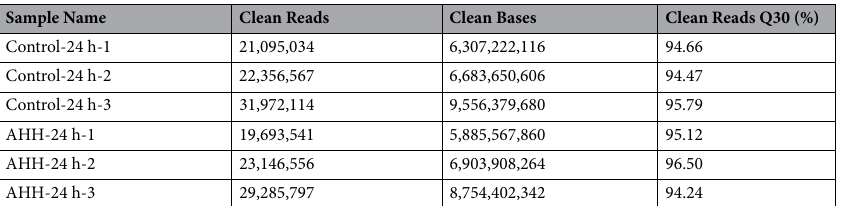
Table 1. Statistical analysis of transcriptome sequencing of the hippocampal tissue of spontaneous hypertensive rats (SHRs) exposed to acute hypobaric hypoxia (AHH) for 24 h in the AHH group compared to those in the control group. Sample name: sample name of the sample information sheet. Clean reads: total number of paired-end reads in the clean data. Clean bases: total number of bases in the clean data number. Clean reads Q30: the percentage of bases with clean data quality value higher than or equal to